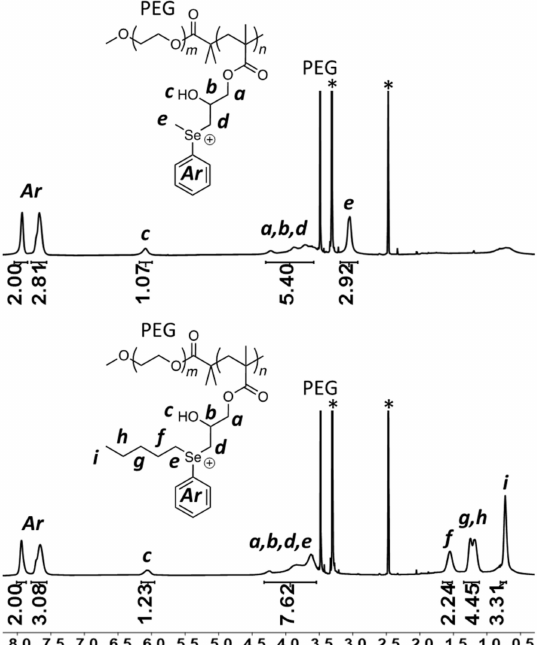
Figure 5. 1 H-NMR of 10 and 11 in DMSO- d 6 . The residual solvent signals from DMSO and water are shown with the help of an